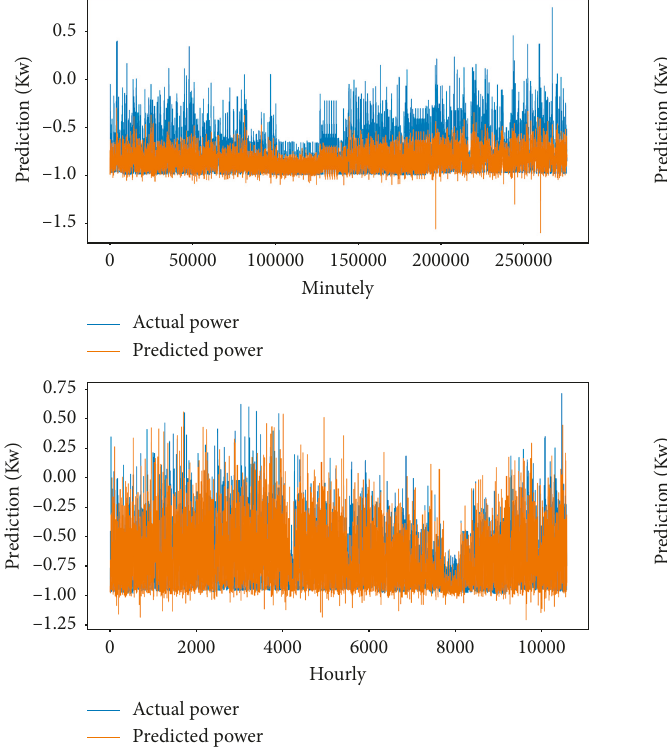
Figure 12: Forecasting results obtained through the proposed method for the household power dataset over day and week time horizons. Table 4: Detailed comparative analysis with competitive state of the arts with the proposed method on the household power